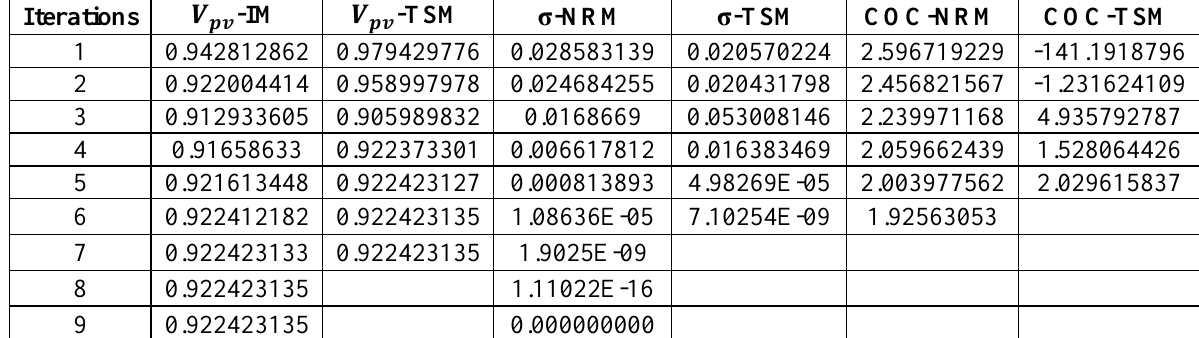
Table 1: The obtained values using NRM and